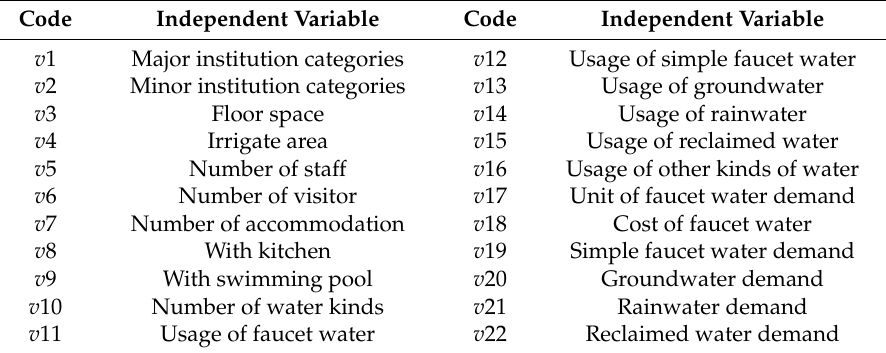
Table 3. Independent variables adopted in this